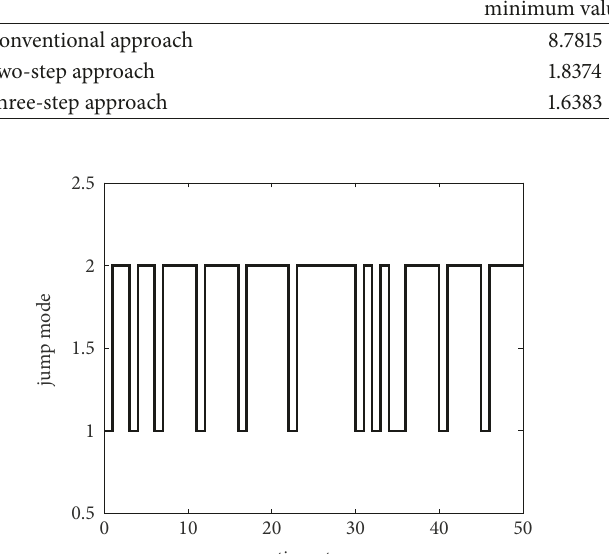
Figure 1: Sample path of the nonhomogeneous Markovian chain.